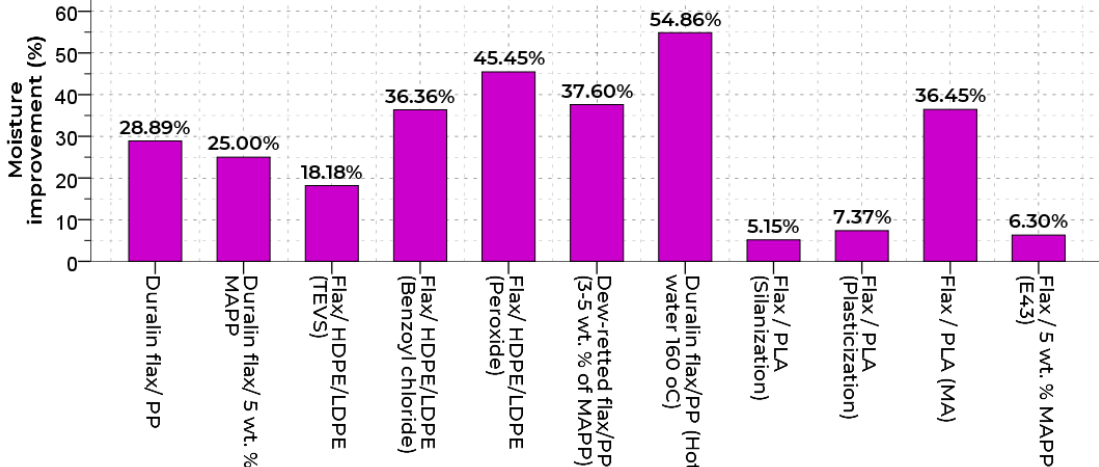
Figure 8. Improvement of the moisture absorption behavior of flax fiber-based composites. 38 vol.% flax fiber/PP (1440 h) [214], 10 wt. % flax fibers/HDPE/LDPE (24 h) [215], dew-retted (RFB) flax/PP and Duralin upgraded flax/PP (RH = 100% for 4500 h) [146], flax fiber/PLA (408 h) [216], 60 wt. % short flax fiber bundle/5 wt. % MAPP (E43) (5040 h) [135].